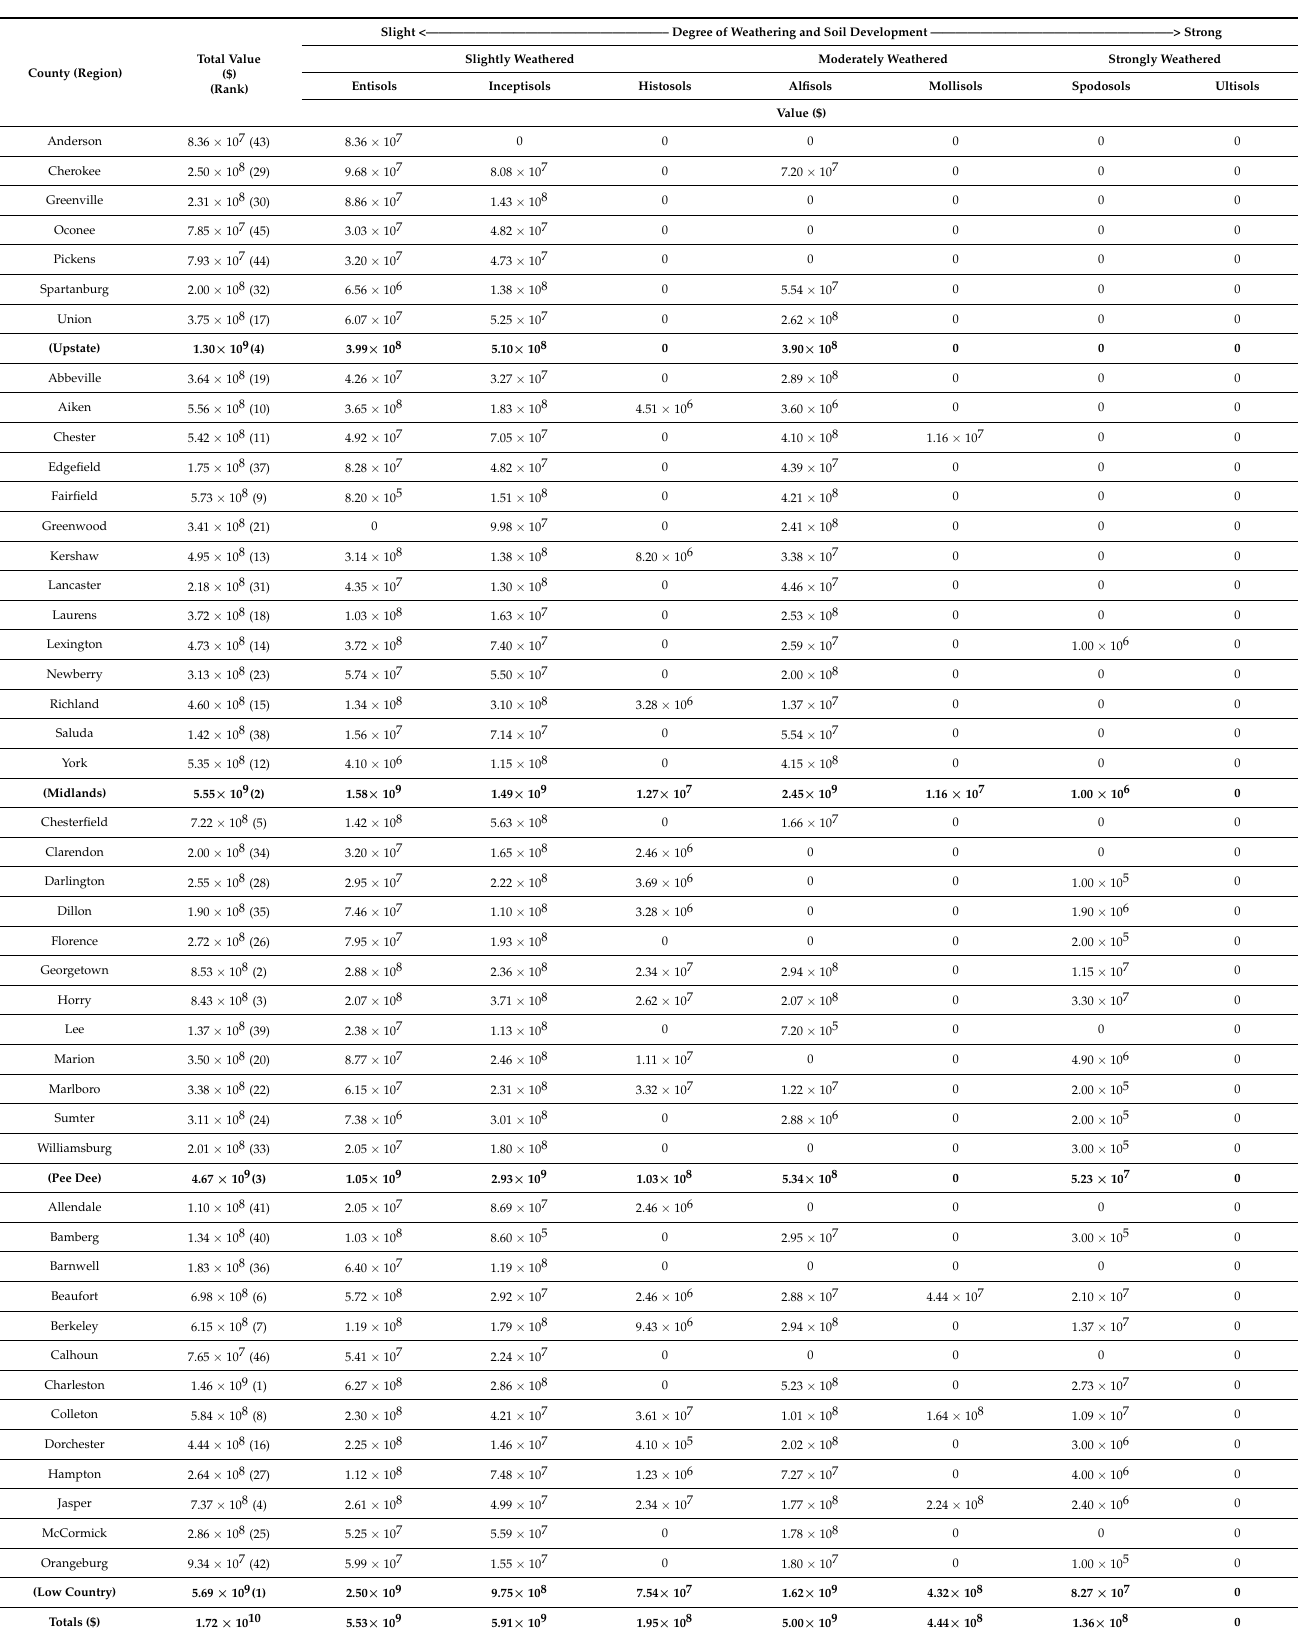
Table 8. The total dollar value of soil inorganic carbon (SIC) by county, region, and soil order for the state of South Carolina (U.S.A.), based on mid-point soil inorganic carbon (SIC) numbers for the upper 2 m from Guo et al. 2006 [18] and a social cost of carbon (SC-CO 2 ) of $46 per metric ton of CO 2 (2007 U.S. dollars with an average discount rate of 3% [17]). Slight<———————————————————–DegreeofWeatheringandSoilDevelopment———————————————————–>Strong County(Region) Anderson